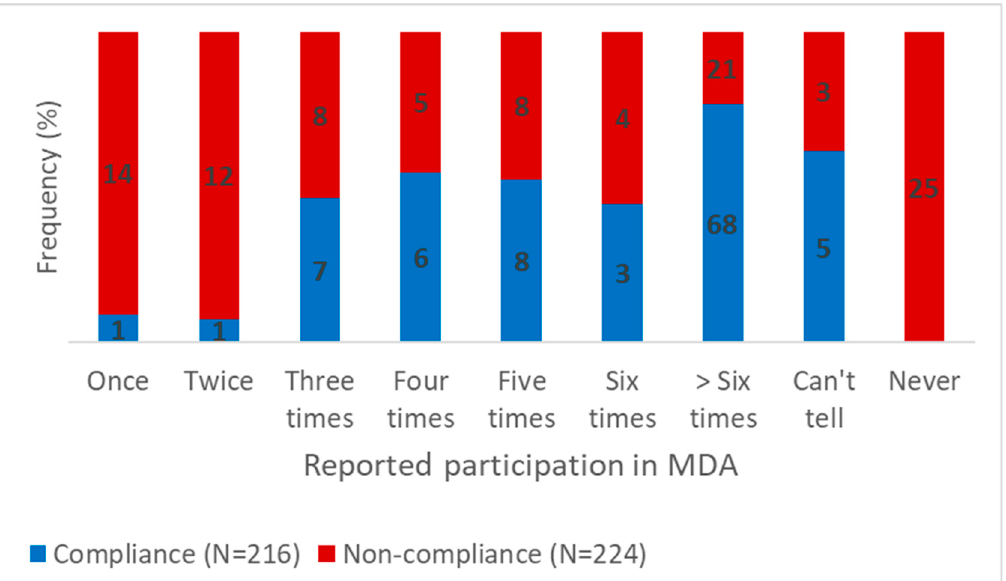
Figure 3. Number of times respondents reported taking the MDA drugs since its introduction in the district.